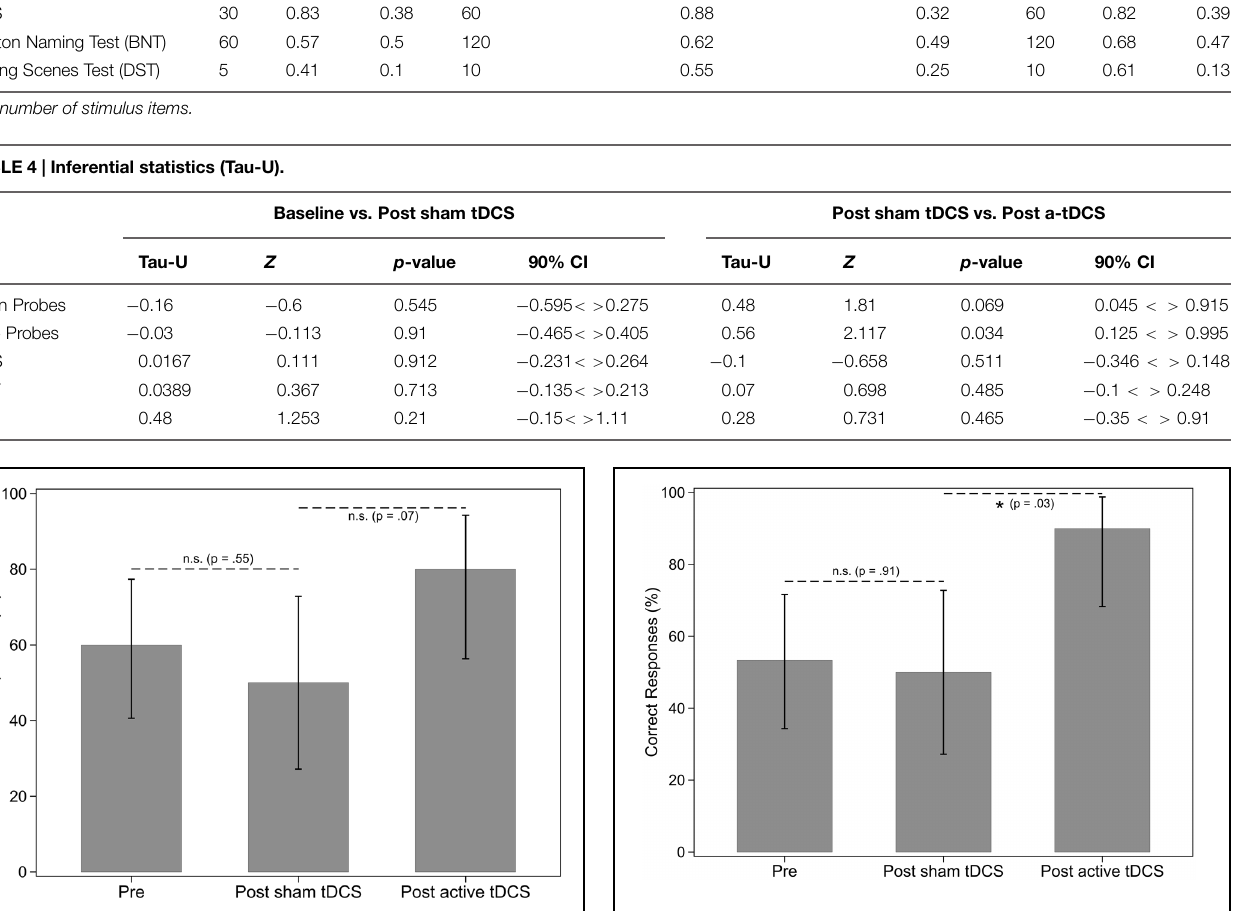
FIGURE 4 | Percentage of verbs in sentences correctly identified, by treatment phase. Error bars: 95%